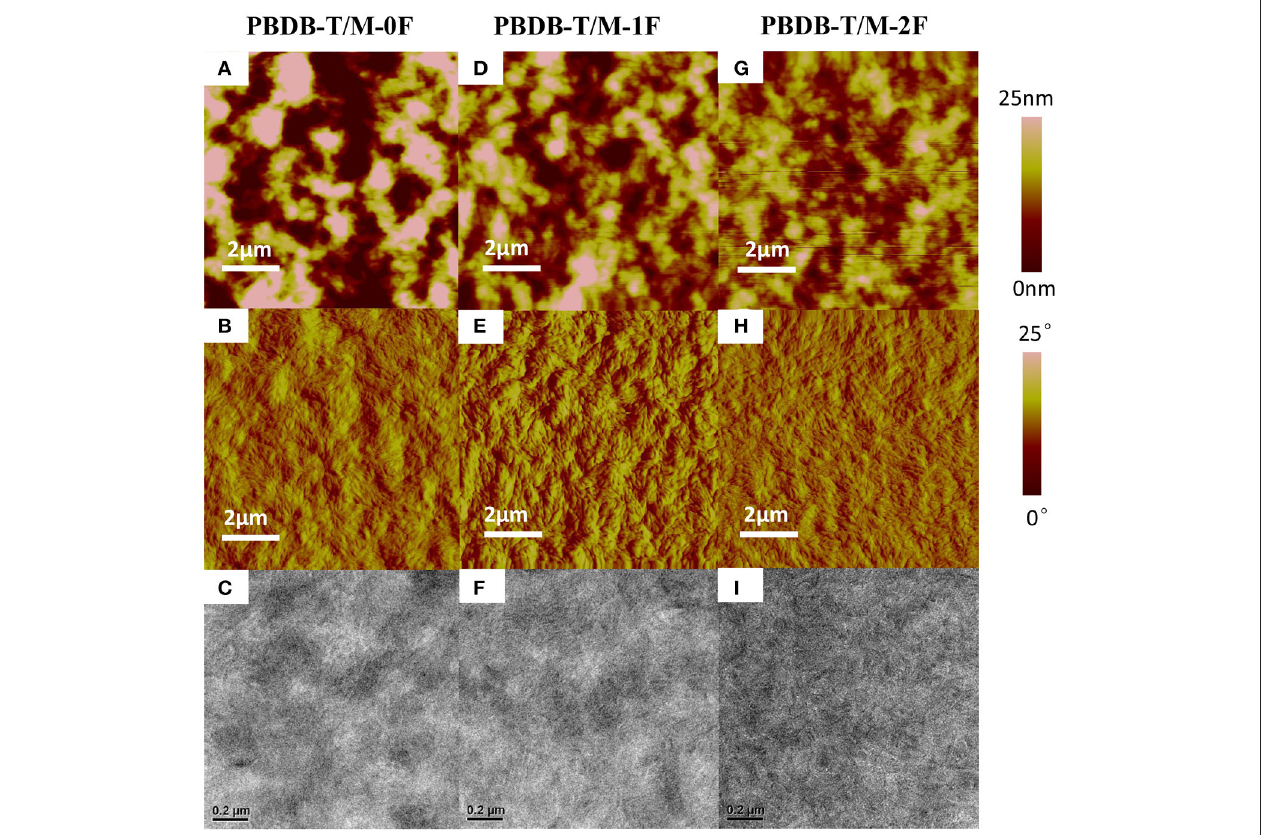
FIGURE 4 | Tapping-mode AFM (A,D,G) topography and (B,E,H) phase images and (C,F,I) TEM images of (A–C) PBDB-T/M-0F, (D–F) PBDB-T/M-1F, (G–I) PBDB-T/M-2F blend